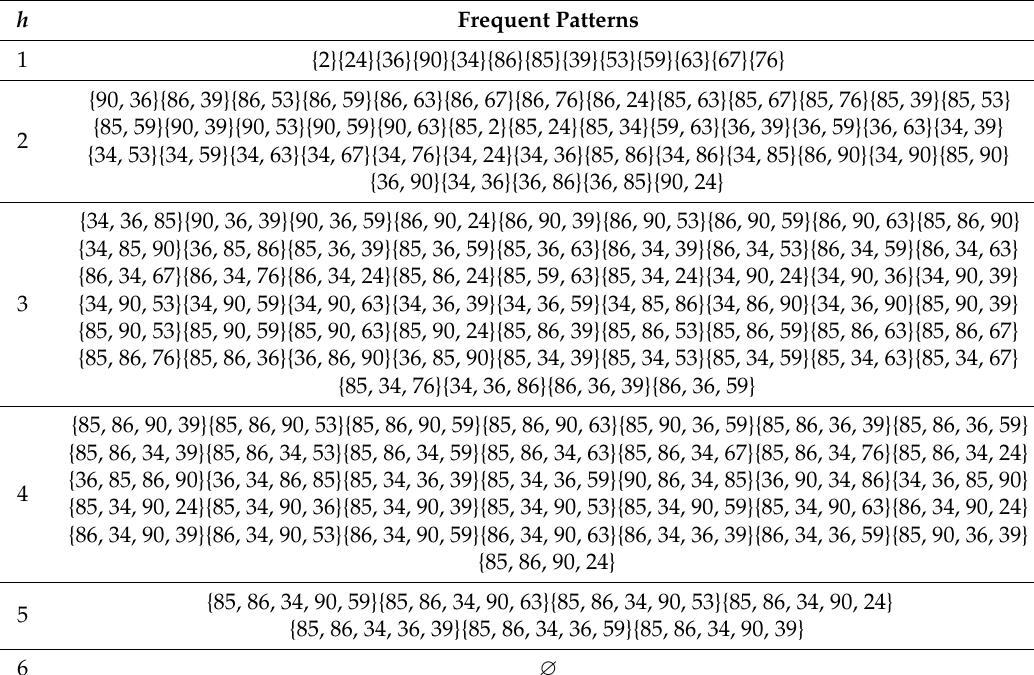
Table 7. Frequent patterns identified by ETPAM for the Mushroom